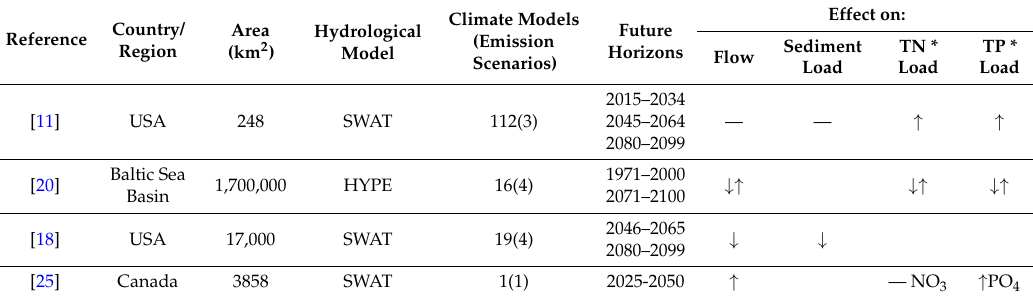
Table 1. Selected studies assessing climate change impact on water quantity and quality. The last four columns show the dominant direction of simulated effects of climate change on different parameters (see legend below the